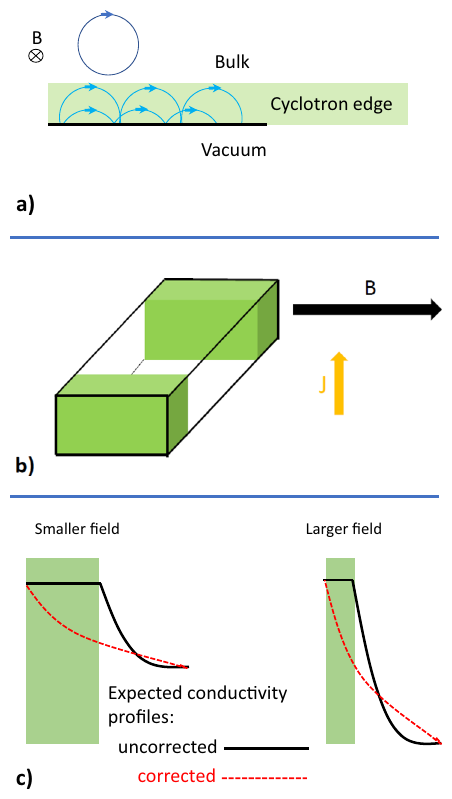
Fig. 6 Static skin effect. a When ω c τ ≫ 1, bulk carriers whirl along cyclotron orbits numerous times without being scattered. This yields a semiclassical account of the large orbital magnetoresistance in compensated semimetals with ballistic carriers like Bi. The cyclotron orbits are interrupted at the edge of the sample (in green). When re fl ections are specular, magnetoresistance is canceled in this region. b In this semiclassical picture, the excess of conductance when the fi eld is parallel to a surface arises thanks to additional conduction along dissipation-free edges. c In a larger magnetic fi eld, the cyclotron edge is narrower and the difference between bulk and boundary conductivities is larger. Therefore, the conductivity pro fi le is expected to evolve with increasing magnetic fi eld. It is sketched for two different possibilities: (i) the conductivity inside the cyclotron edge does not evolve with depth (solid black line), and (ii) hybridization leads to a smooth variation across the cyclotron edge (red dashed line). Experimentally, the relative conductivity excess does not change above 0.2